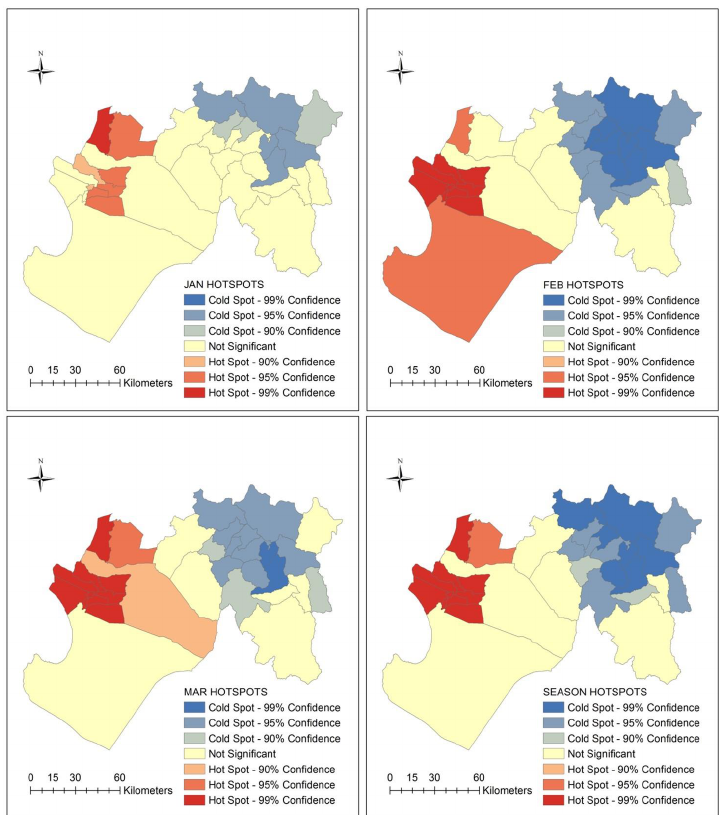
Figure 9. Maps of spatial clusters (hotspots) of the ecosyndemic index at the district-level by month and season from January to March 1998.